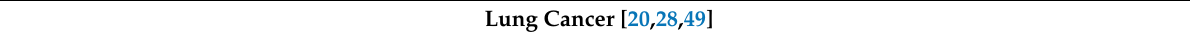
Table 2. FUT8 in